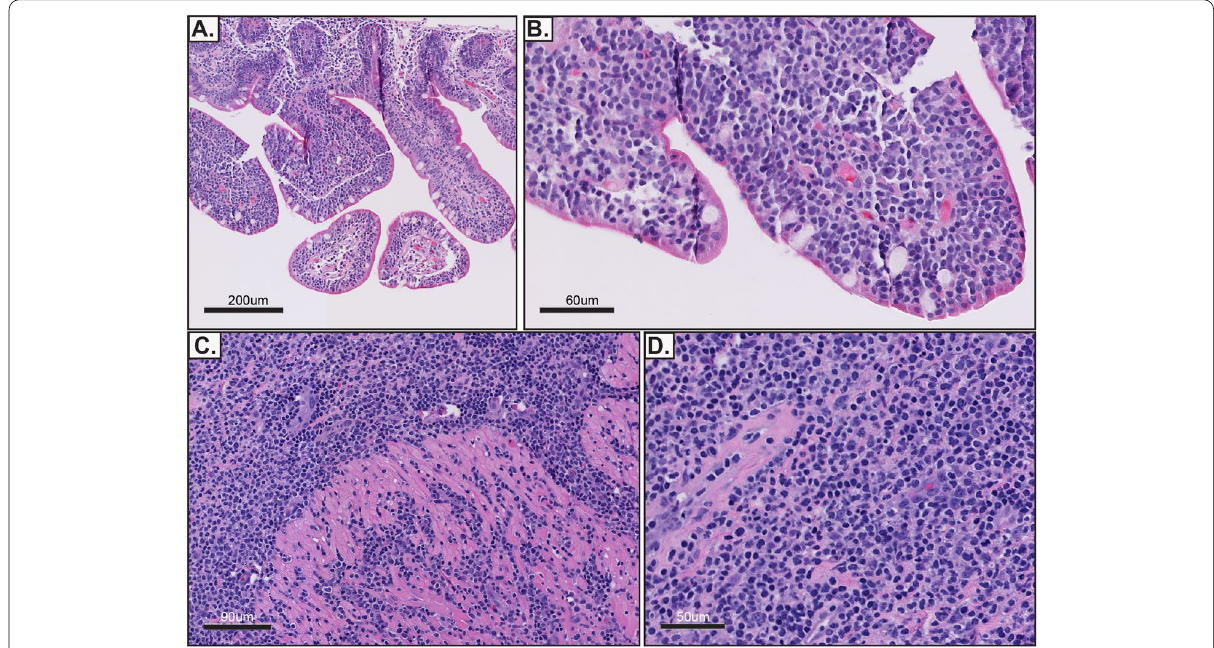
Fig. 2 Representative images from biopsies of the small intestine. A , B Intact intestinal villi can be appreciated with extensive epitheliotropism of small lymphocytes. C , D The cytological atypia is more evident within the intestinal submucosa ( D ). Hematoxylin and eosin stain ( A ‑ D